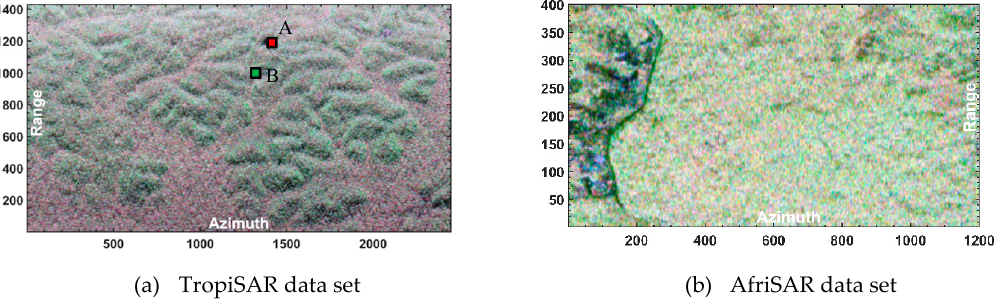
Figure 4. Pauli false color composite of master images of (a) TropiSAR and (b) AfriSAR data campaigns. Point A (ground pixel) and point B (forest pixel) are two analyzed cells.